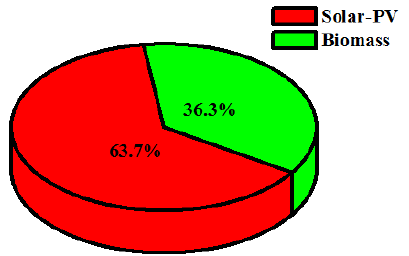
Figure 15. Renewable energy generation percentage for case II (Ba/Bi/S).